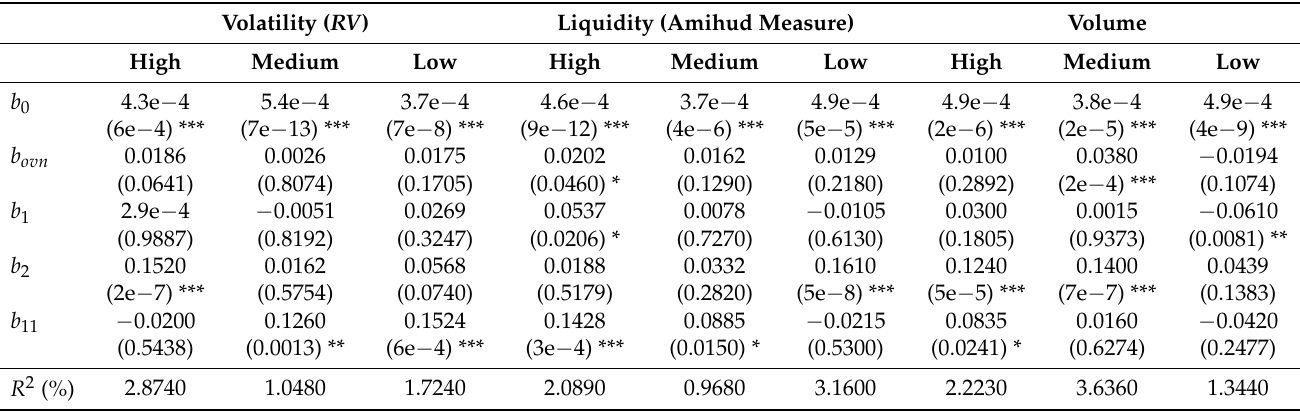
Table 7. Estimation results of Market Intraday Momentum with grouping for volatility, liquidity and